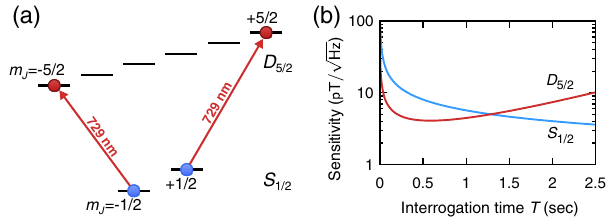
FIG. 6. (a) Relevant transitions for creating the D 5 state. (b) Theoretical shot-noise limited sensitivity of magnetic- field measurements versus interrogation time T for both S 1 D 5 sensor states, showing how spontaneous decay limits the = 2 sensitivity of the D 5 sensor state for long interrogation times = 2 (see